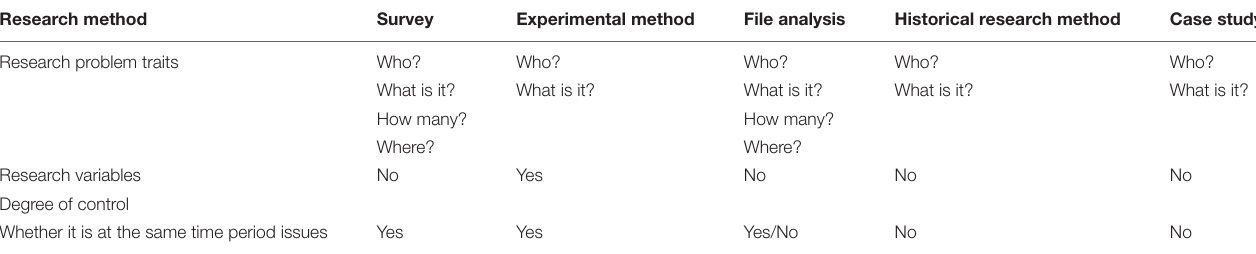
TABLE 1 | Related status of different research method strategies. Research